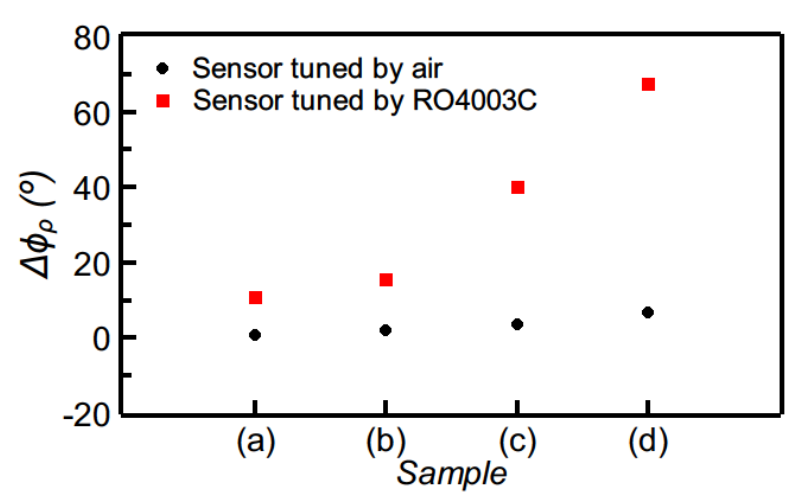
Figure 14. Comparison of the measured differential phase of the reflection coefficient for the sensor of Figure 11 and for the equivalent sensor, but with the sensing line exhibiting a phase of 90° when it is uncovered (i.e., with air as reference material). Reprinted with permission from [64].